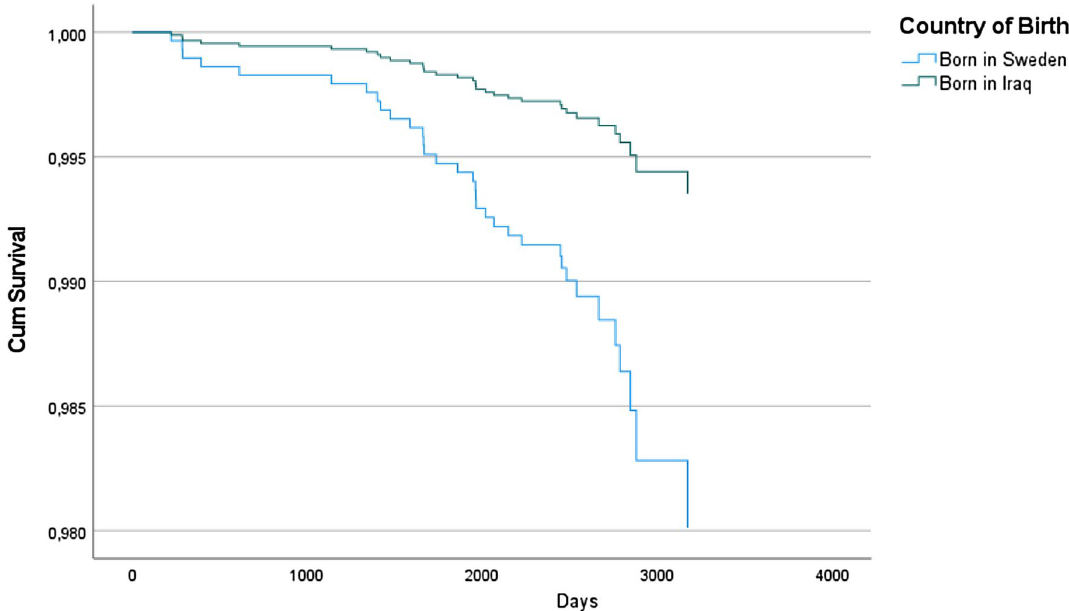
Figure 3. Time to event defined as cancer and death from cancer in a fully adjusted